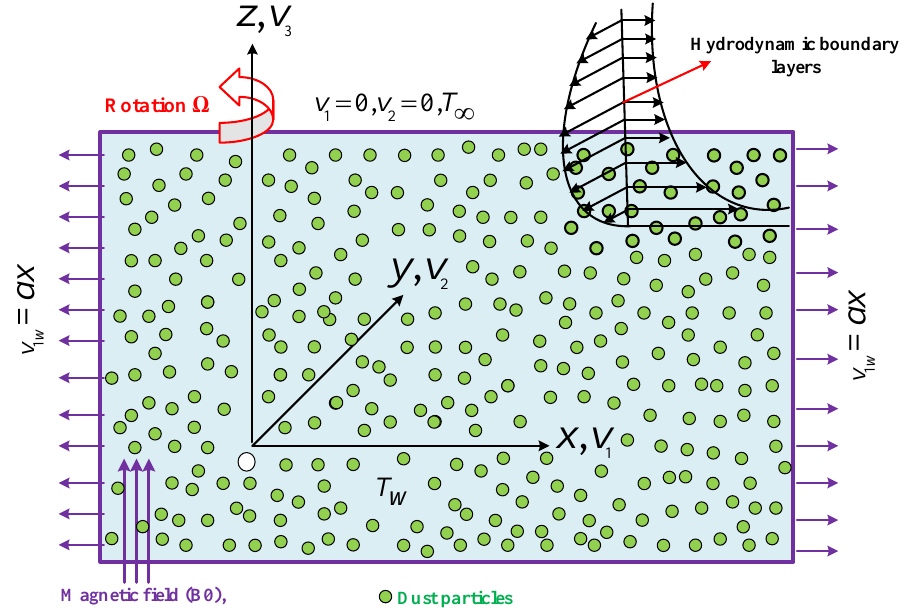
Figure 1. Schematic flow